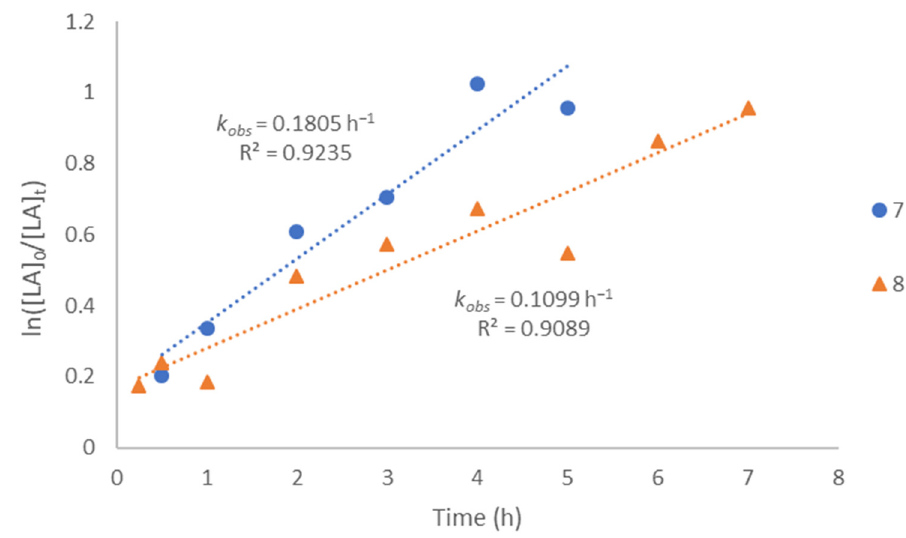
Figure 9. Kinetic plot for the ROP of rac -lactide using complexes 7 and 8 . 100[LA]:[M], [LA] = 1 mol/L, BnOH = 2 μ L, 130 °C.